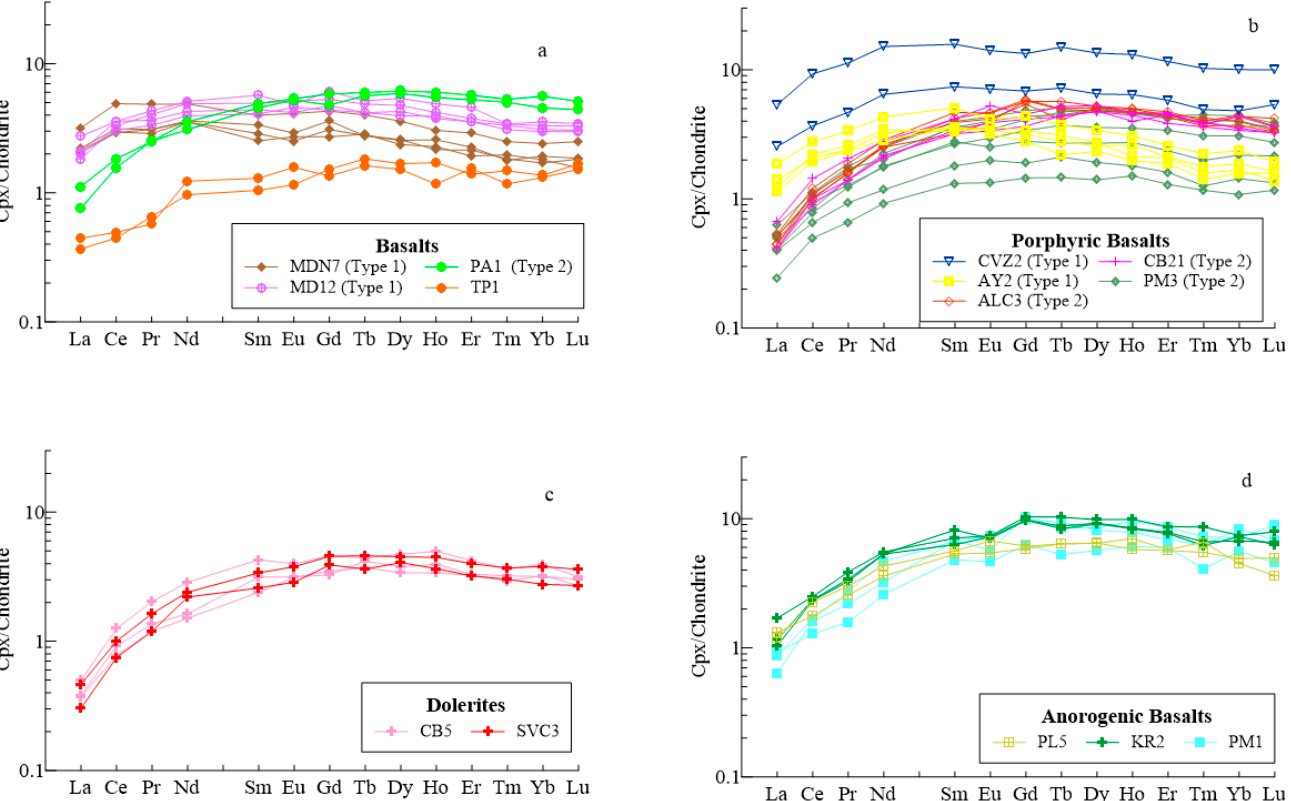
Figure 7. Chondrite-normalized rare earth element patterns of the clinopyroxene phenocrysts from the Yüksekova Complex (Normalizing values are from [52]). ( a ) Basalts; ( b ) Porphyric basalts; ( c ) Dolerites; ( d ) Anorogenic basalts.